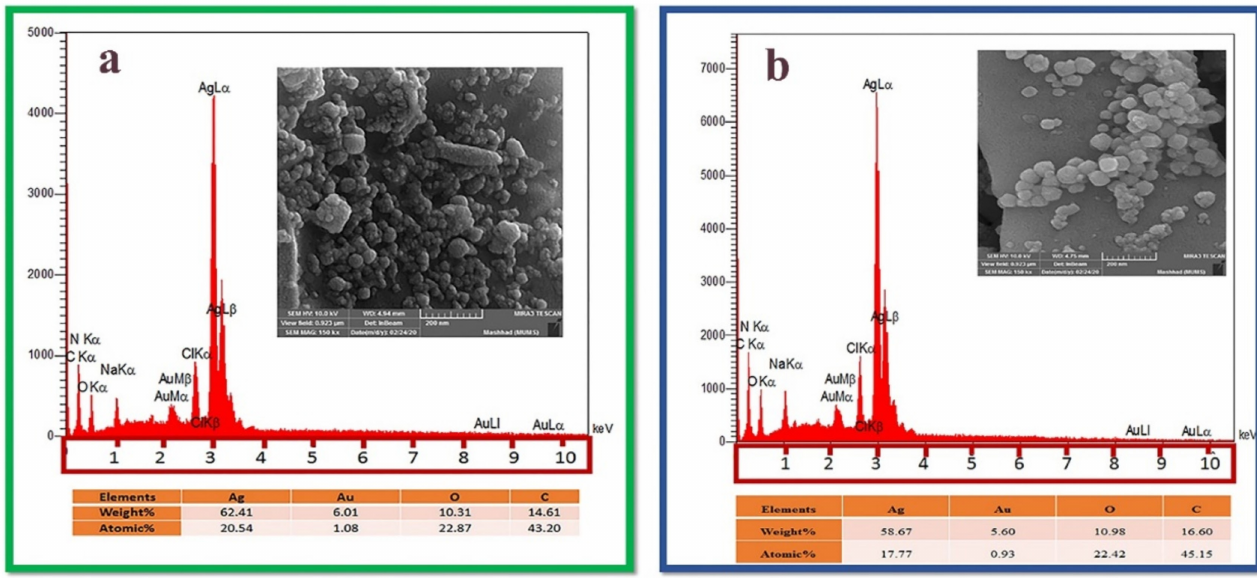
Figure 5. EDX spectrum and chemical composition of ( a ) Au@Ag (P); ( b ) Au@Ag